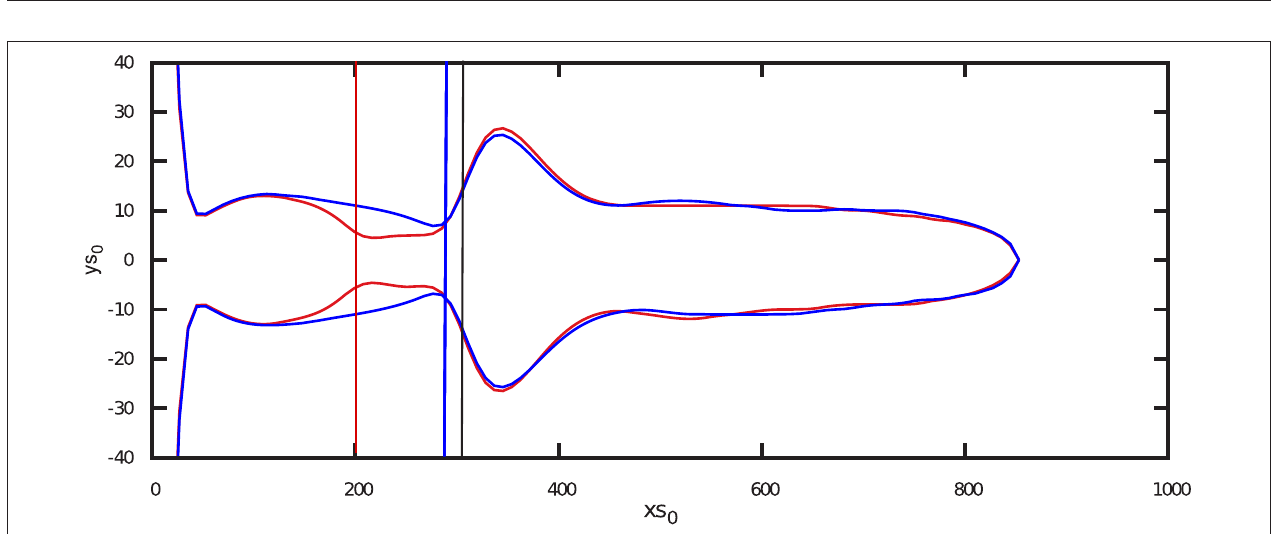
100, right: stratified case at Pe 100. = =